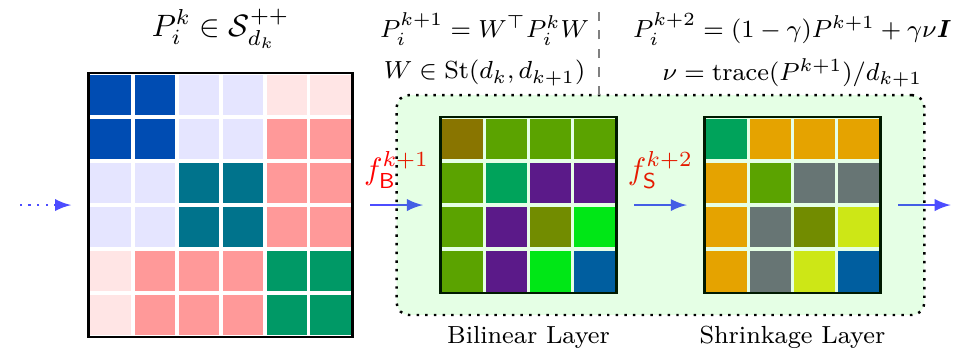
Figure 2. Conceptual illustration of the SPD-Mani-Net for dimensionality